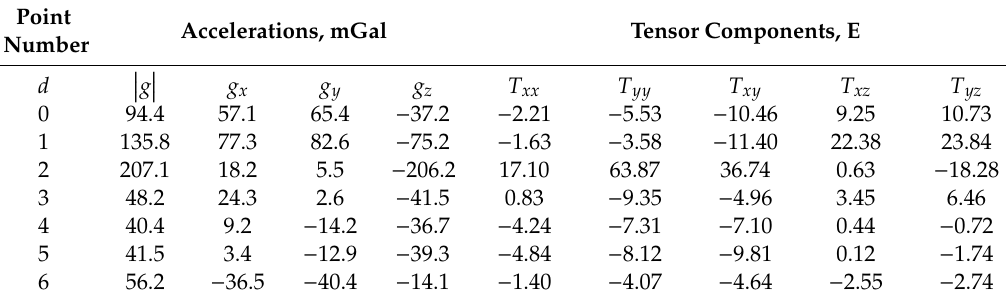
Table 5. Route points characteristics for the region with high-amplitude